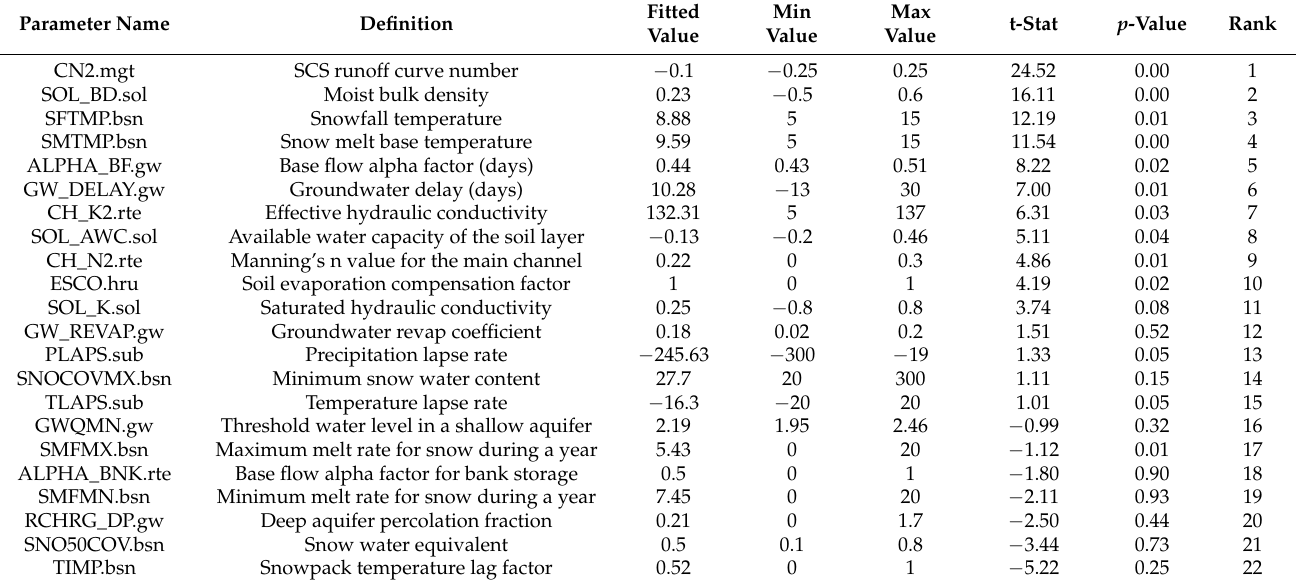
Table 2. Description, ranges, fitted values, and significance statistics of the sensitive